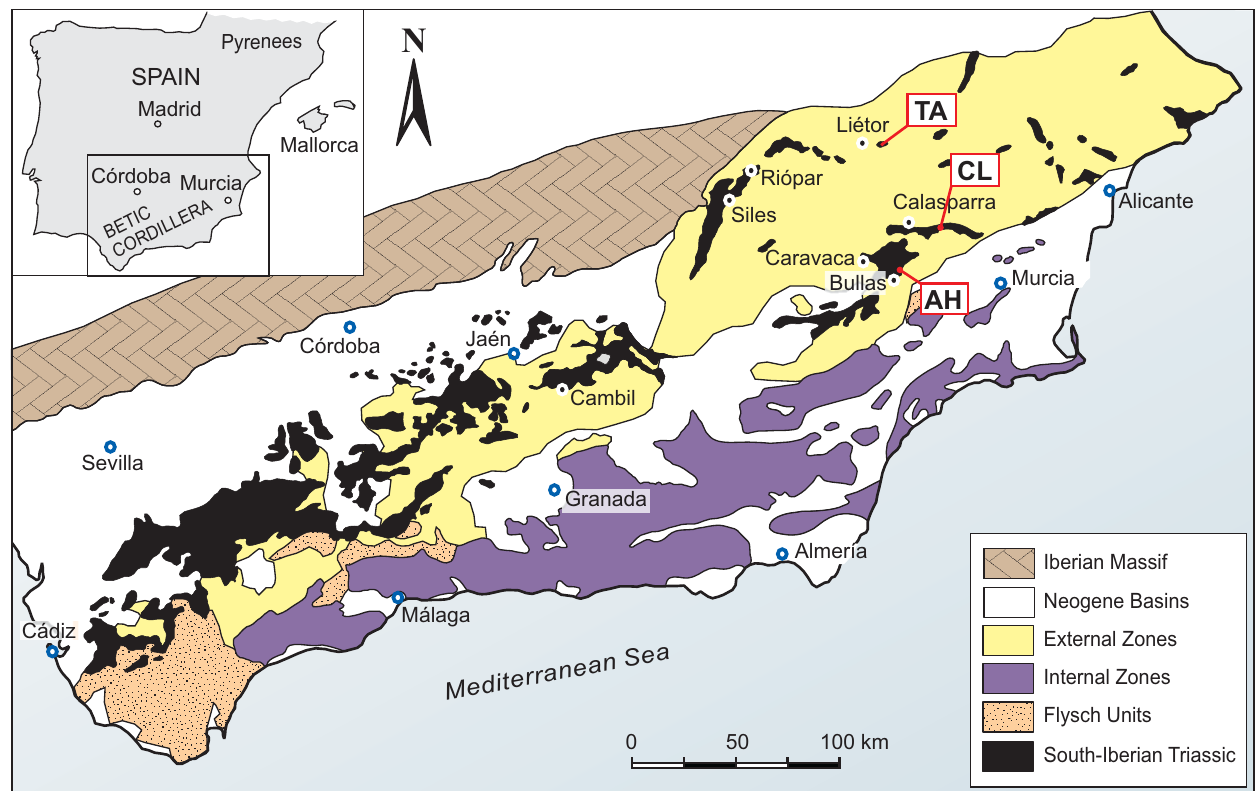
Fig. 1. Geographical and geological setting of the localities studied yielding Ladinian brachiopods in the Betic Range context emphasizing the South- Iberian Triassic outcrops. AH, Arroyo Hurtado section; CL, Calasparra section; TA, Talave